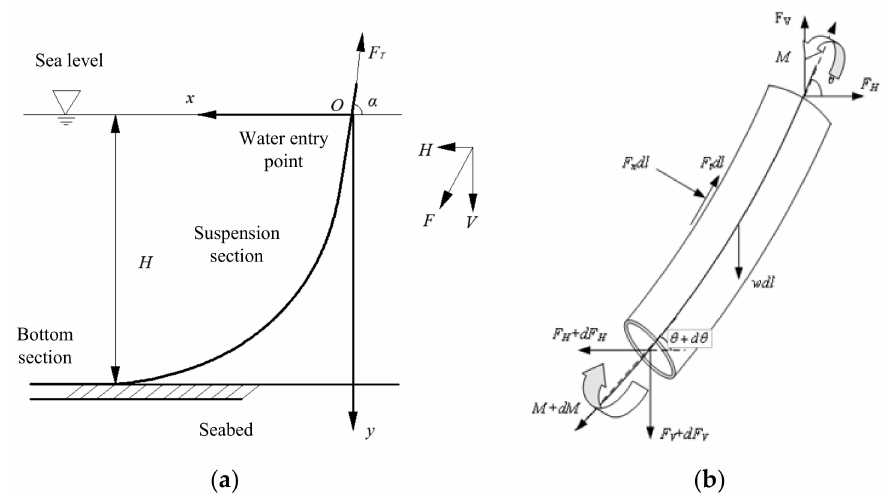
Figure 2. Attitude of underwater pipeline ( a ) and Force of pipeline unit ( b ). F n and F τ are used to calculate the ocean load per unit length. τ represents the drag force of the unit pipeline in the ocean by the current in the normal and tangential directions. It can be obtained by Morison’s semi-empirical Equation